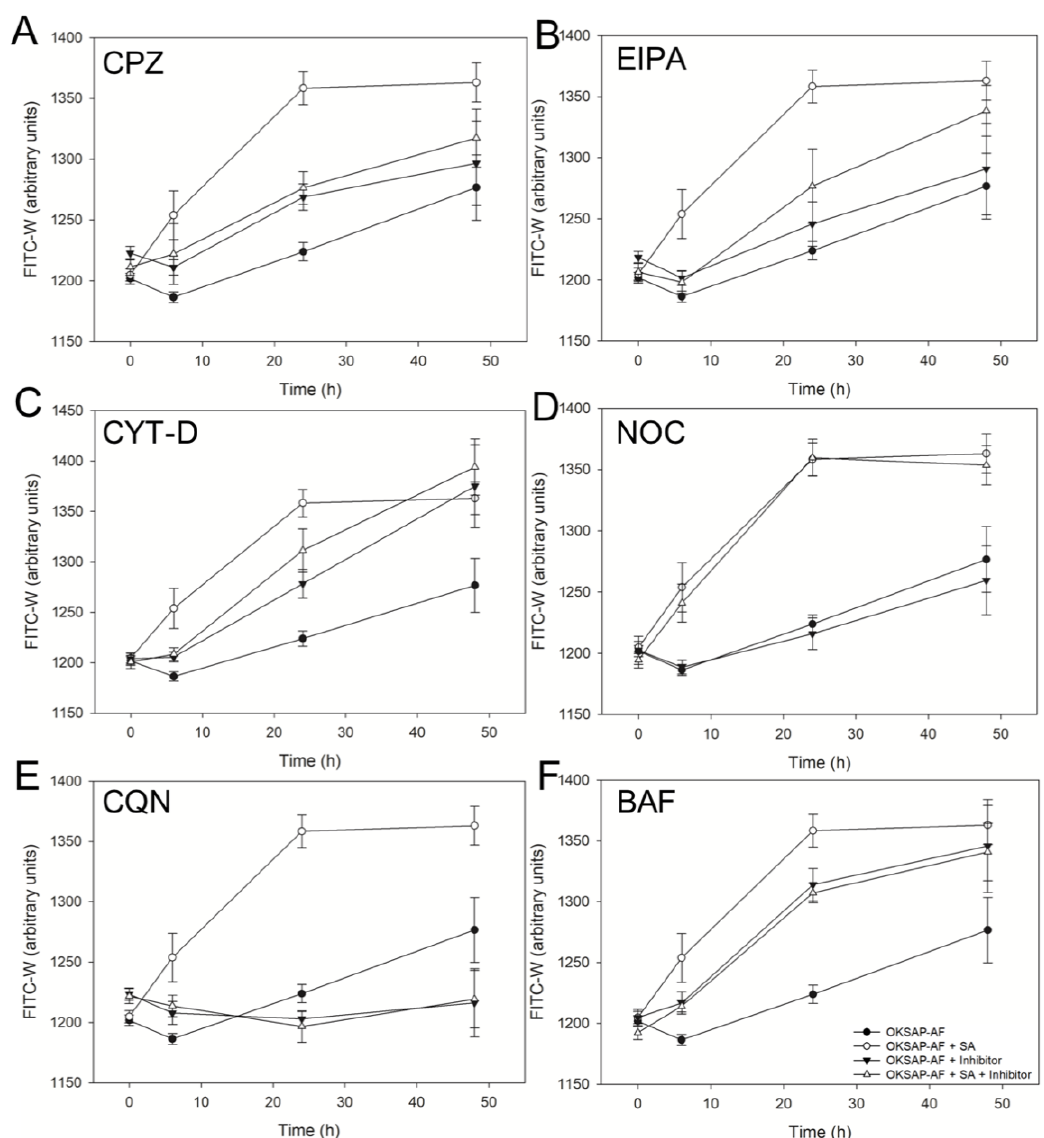
Figure 3. Investigation of the inhibition of SA mediated endolysosomal escape of OKSAP-AF in Daudi Cells by pharmacological agents as measured by pulse width analysis. The effect of chlorpromazine ( A ), EIPA ( B ), cytochalasin D ( C ), nocadazole ( D ), chloroquine ( E ), and bafilomycin A1 ( F ) on the SA mediated endolysosomal escape of OKSAP-AF in Daudi cells. Charts show the changes in FITC-W over time in cells treated with 1 µg/mL of SA in the presence ( △ ) and absence ( ○ ) of inhibitor. Untreated control cells are shown in each chart for comparison in the presence ( ▼ ) and absence (●) of inhibitor. Each datum point represents the calculated mean of three experiments each performed in duplicate and error bars one standard deviation either side of this mean.